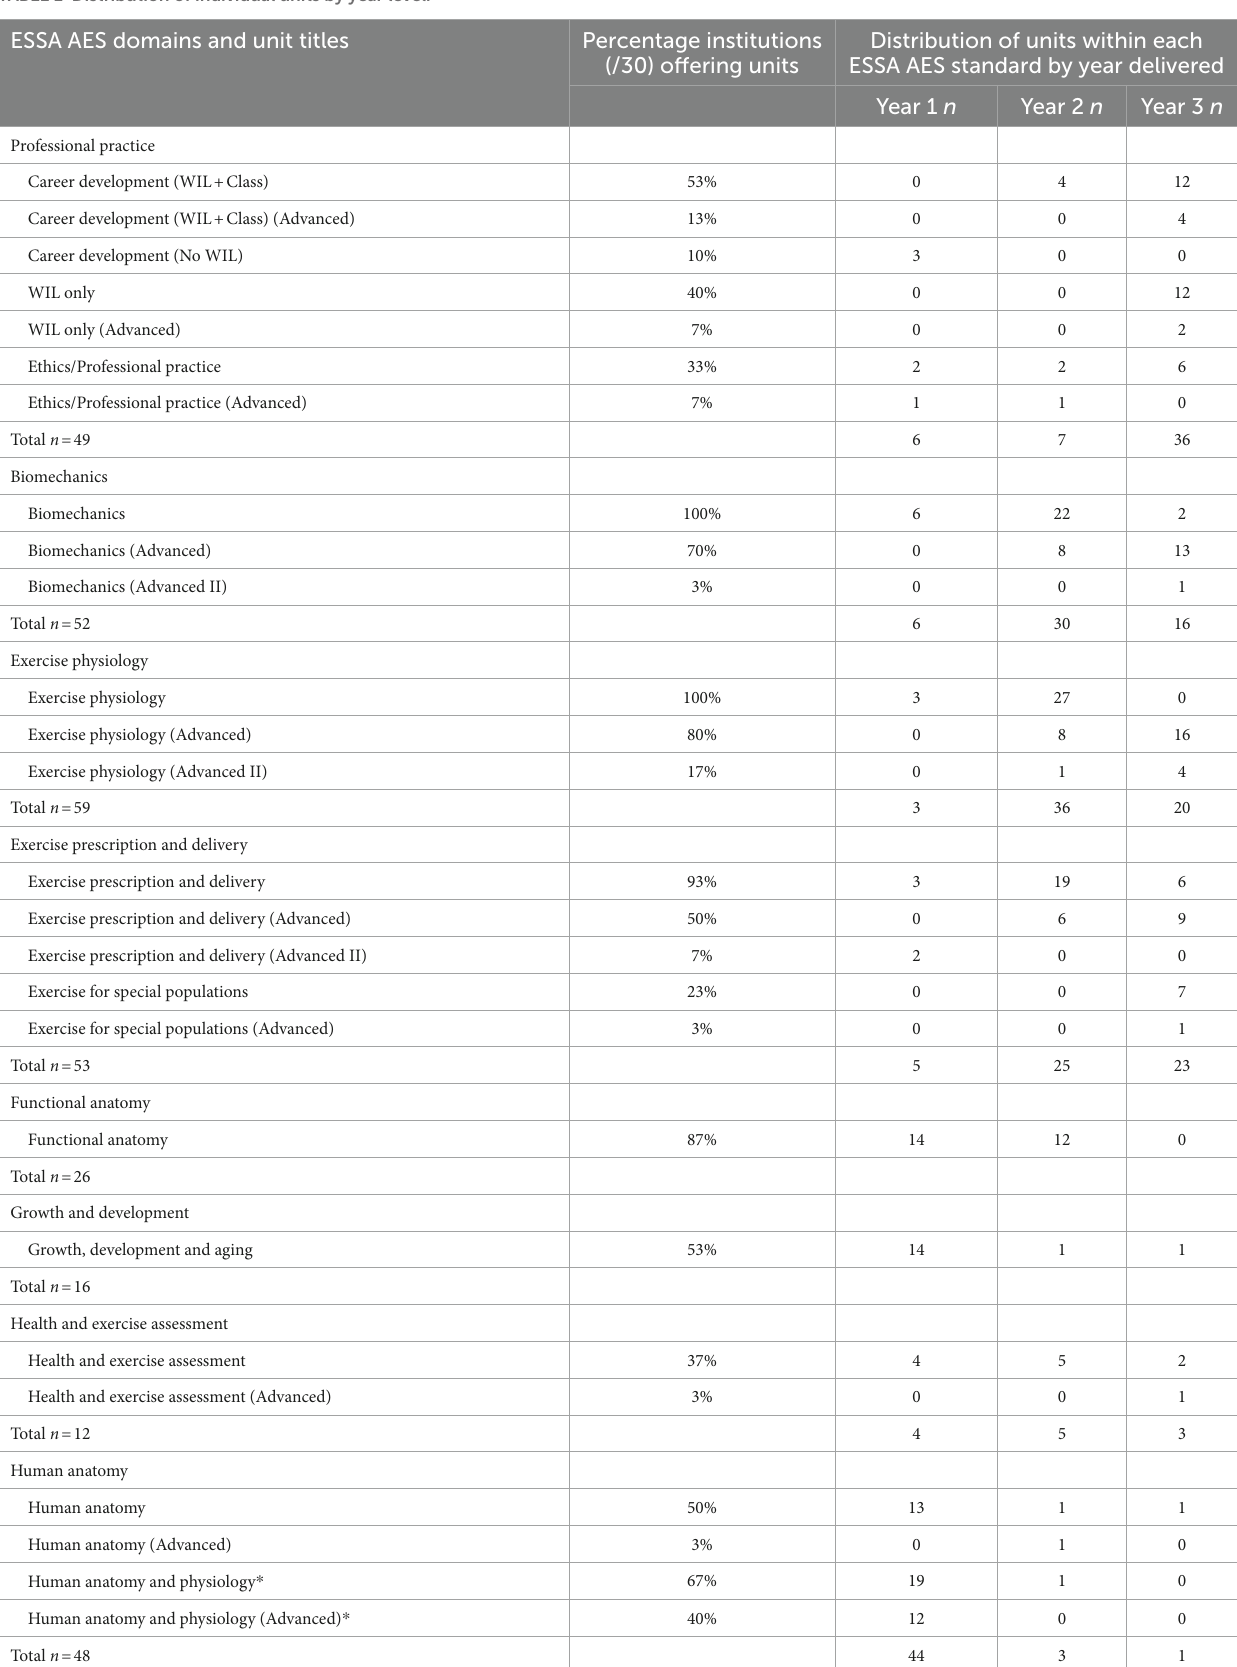
TABLE 1 Distribution of individual units by year level. ESSA AES domains and unit titles Percentage institutions